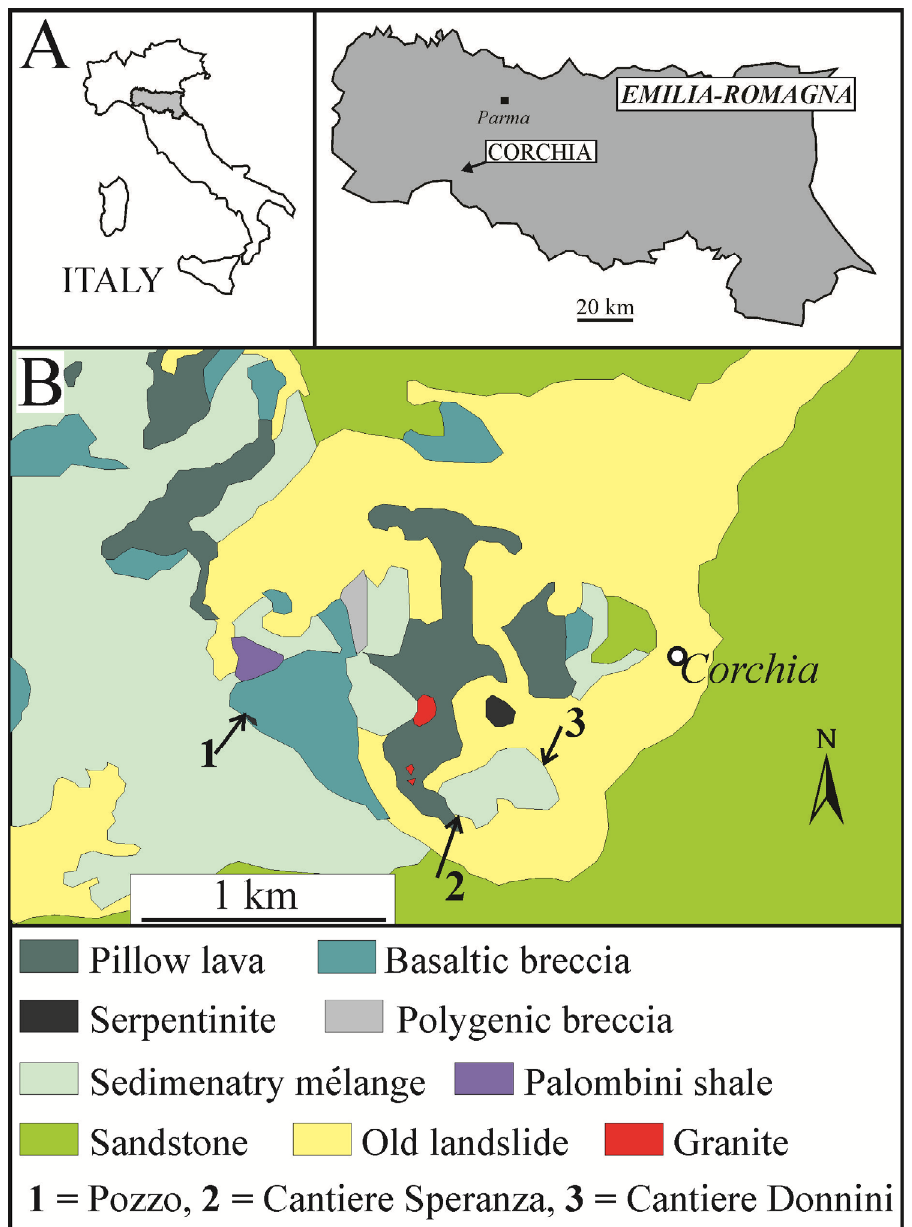
Figure 1. ( A ) Geographical location of the Corchia ophiolite and ( B ) geological map of the Corchia ophiolite (modified after the Geological Map of Italy, Sheet 216, Borgo Val di Taro [8]) showing the location of the investigated